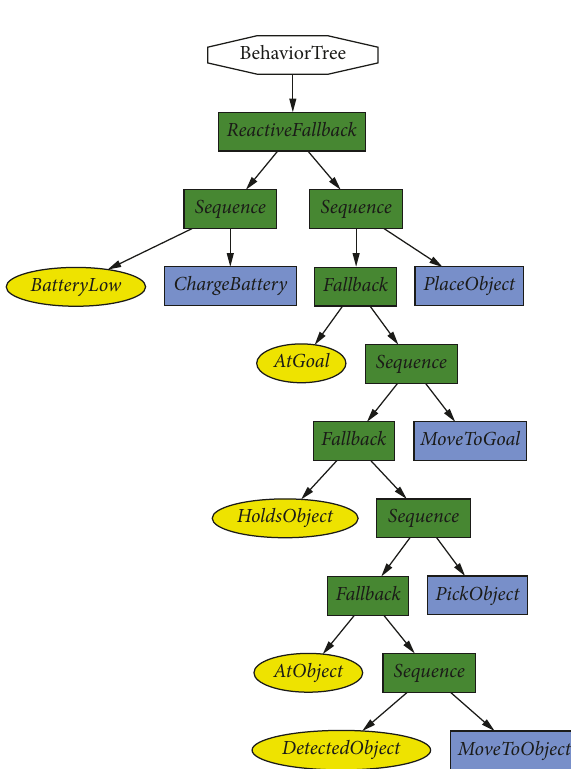
Figure 12: The reactive deliberative plan by adding a contingency on battery